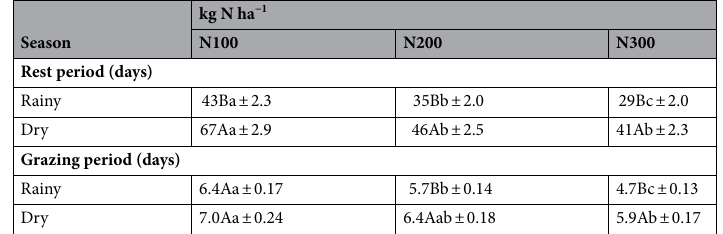
Table 3. Averages and standard error of mean (±) for rest and grazing periods of P. maximum cv. Mombaça guinea grass pastures subjected to rotational stocking and fertilized with three nitrogen levels, during the rainy and dry season. Values followed by different letters, lower case in row and upper case in column, were significantly different according to the Tukey test at P < 0.05.